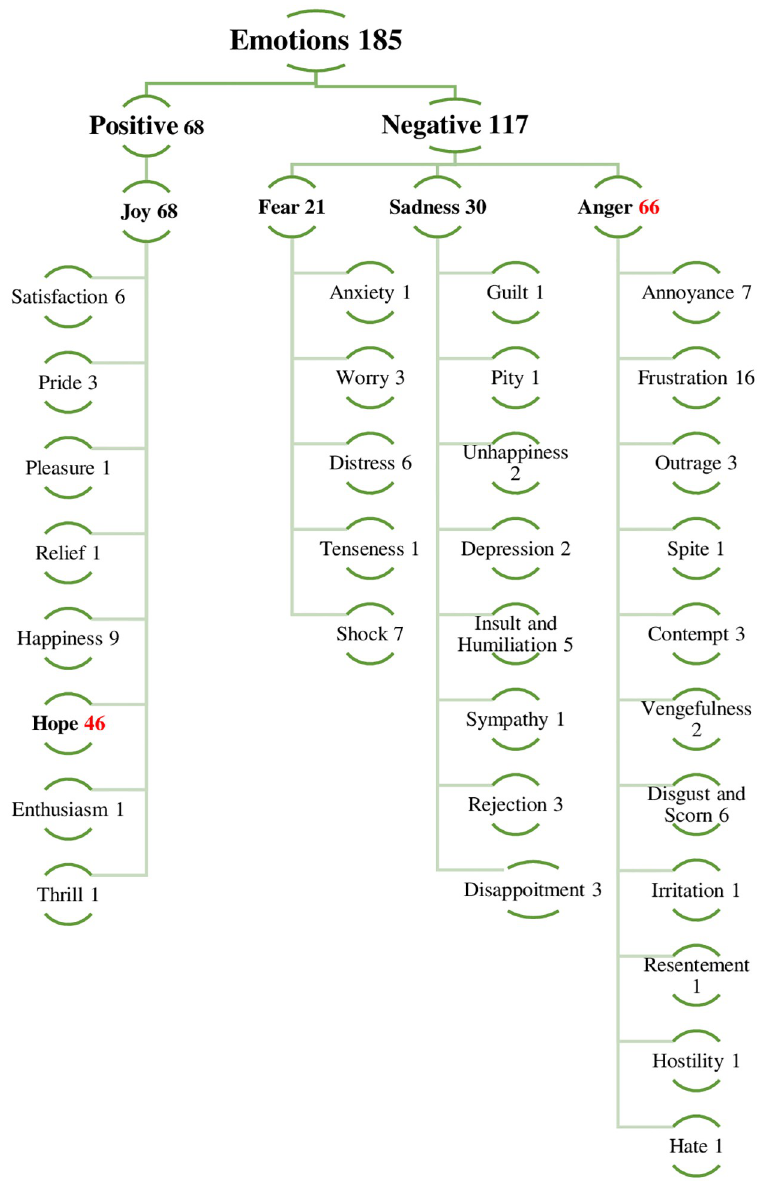
Fig 2. The tree of emotions. Source: